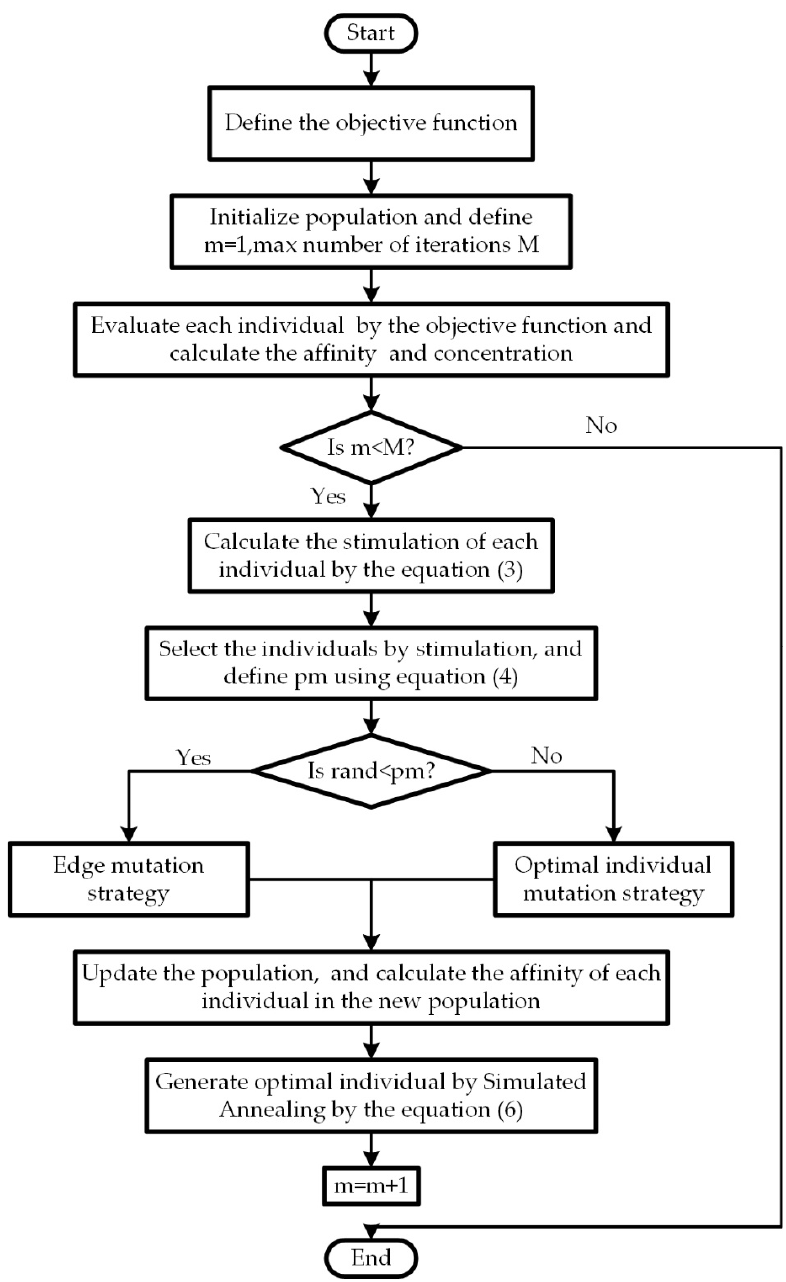
Figure 2. AIAGS. Figure 2.